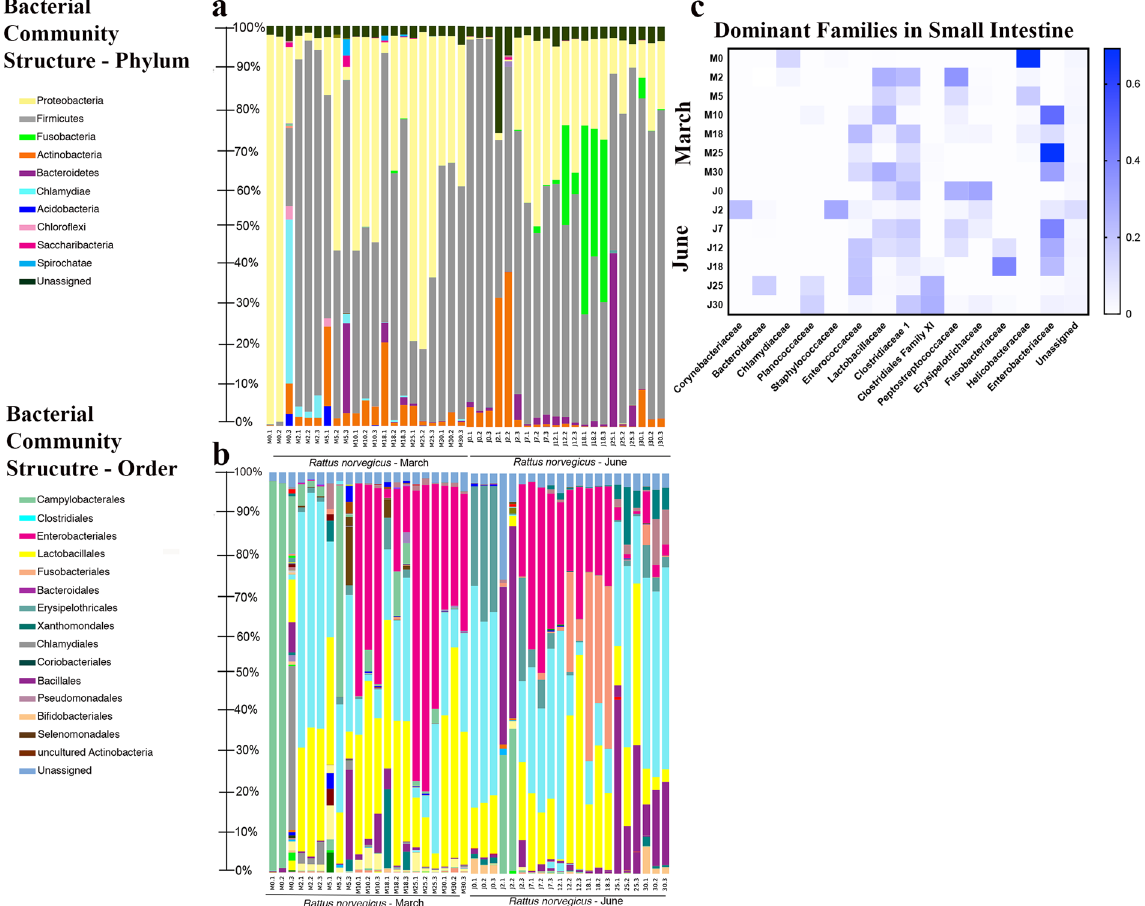
Figure 6. Bacterial community composition for rat intestine-associated samples. ( a ) Phylum; ( b ) Order; ( c ) Family (taxa representing ≥ 1.0% of the entire data set over